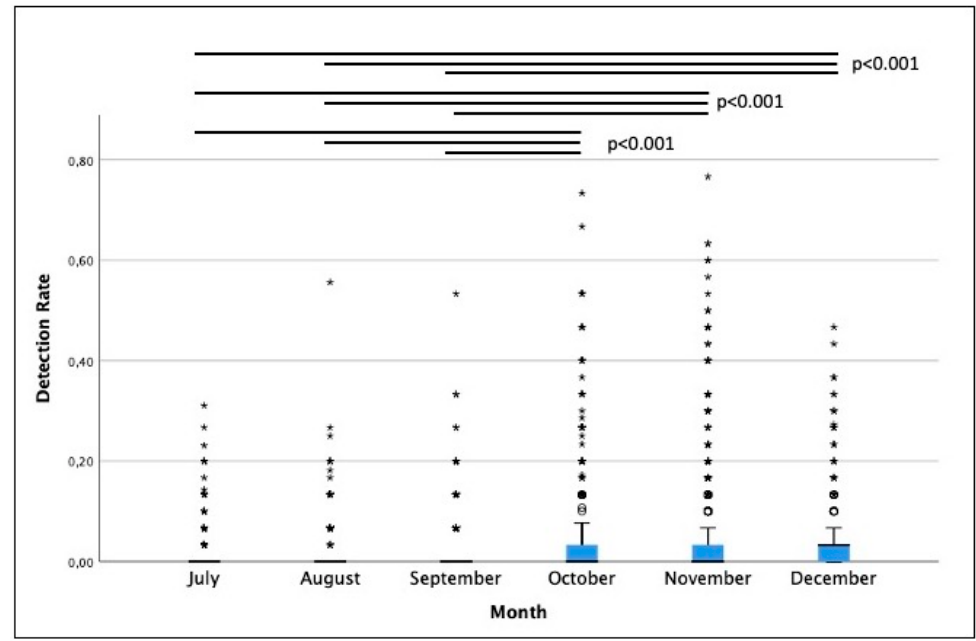
Figure 5. Boxplot of the monthly detection rate. The upper and lower sides of the box represent the first and third quartiles of the sample distribution and shows the width of the middle half of the distribution. The line inside the box instead represents the median. The whisker, the segment that starts from the box and extends upward, indicates the dispersion of values below the first quartile and above the third quartile that are not classified as outliers. Outliers are identified as small circles for “out” values and as stars for “extreme” values. Black bars represent significant differences between pairs of months.